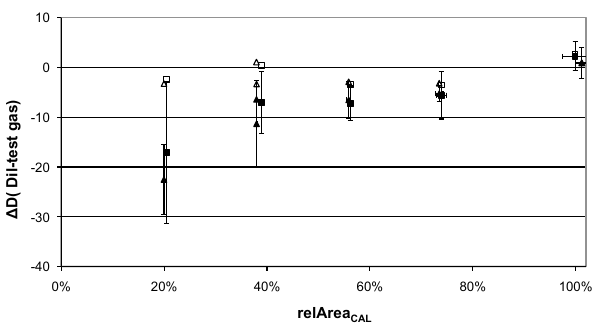
Fig. 5. The non-linearity for the two calibration gases CAL-2 (tri- angle, δ D= − 19‰) and CAL-3 (square, δ D= − 164.9‰) shows no significant dependence on their δ -value (closed symbols with er- ror bars evaluated with ISODAT NT5), which allows SPI to correct both (open symbols) using only a single parameter to lower the de- rived median background on mass 3. The error bars represent the standard deviation of repeated